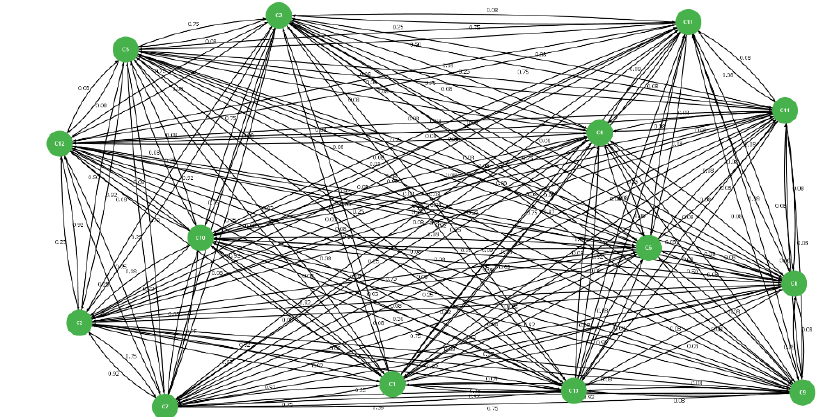
Fig. 1. Graphical representation of overall factors of FCM.